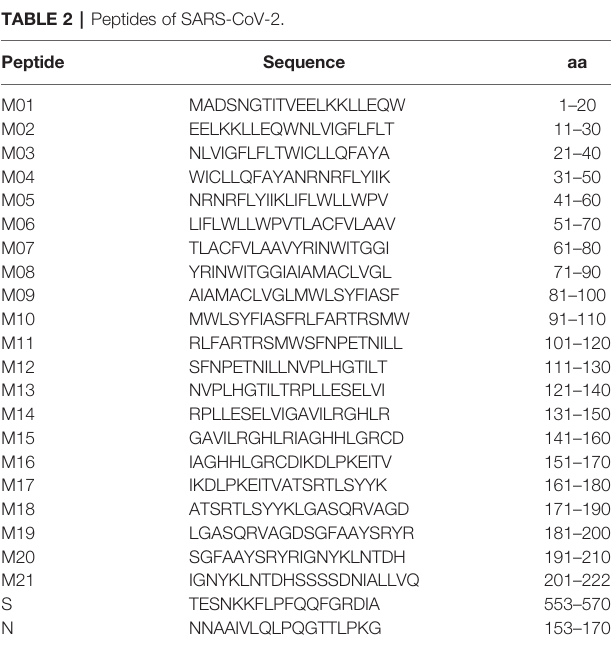
TABLE 2 | Peptides of